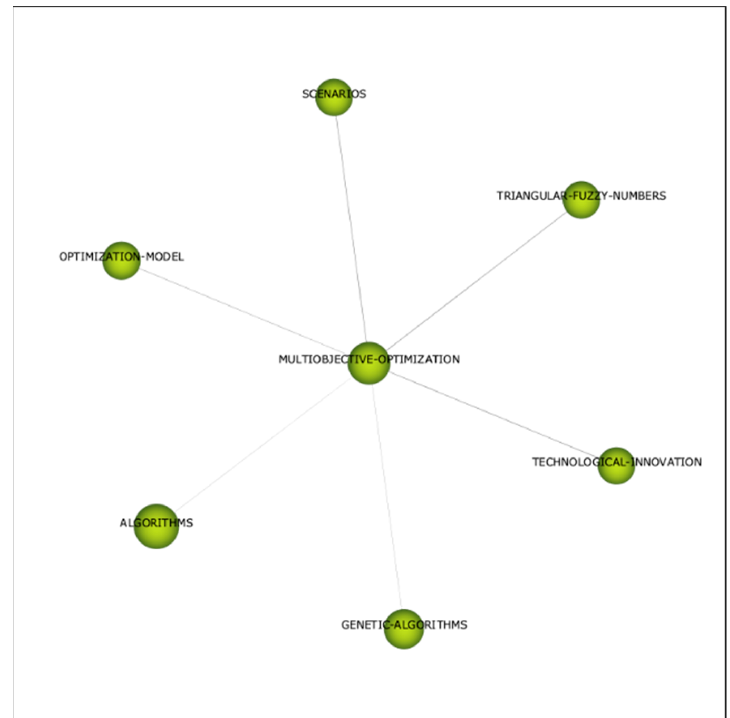
Figure A9. Multiobjective-optimization cluster network.